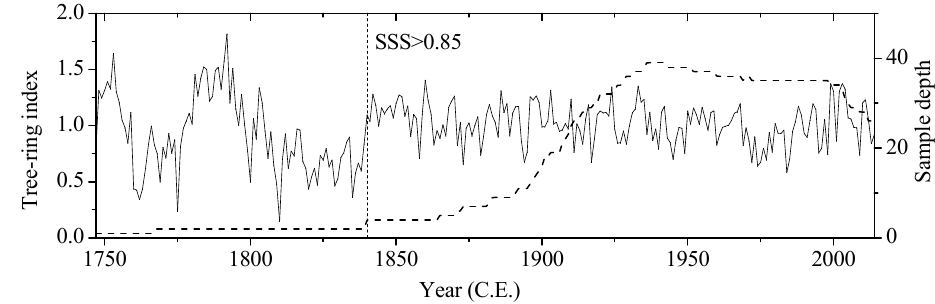
Figure 2. Tree-ring-width chronology (STD) in the Chu River Basin.